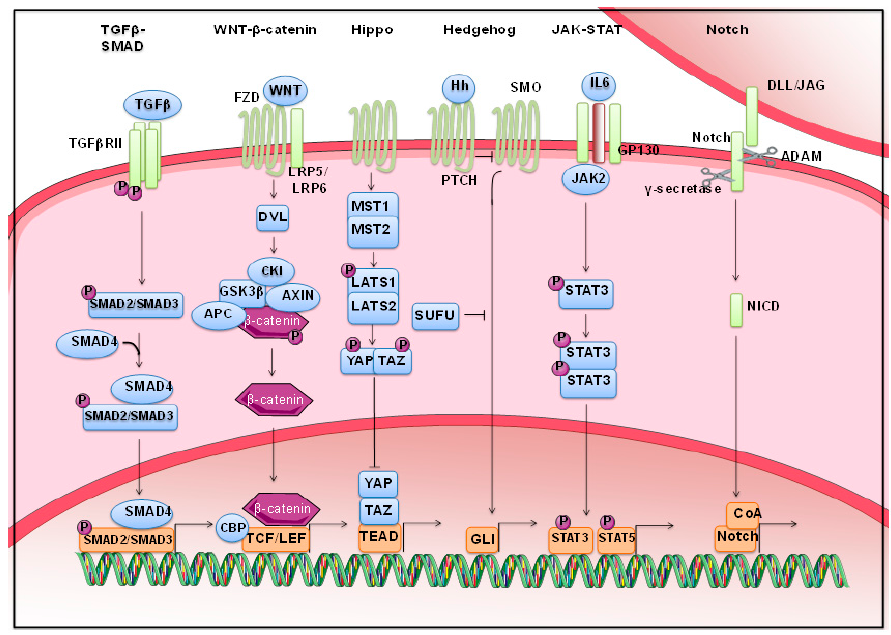
Figure 2. CSCs-activated signaling pathways: Schematic representation of the signaling pathway responsible for induction and maintenance of CSC state. The transcription factors, co-factors, main nodes reported are targetable by drugs. (Adapted from Pattabiraman and Weinberg, Nat Rev Drug Discovery, 2014 [44]). Table 1. Prevalence of CSCs-activated signaling pathways in solid tumors accordingly with outcome: Results obtained by R2 on line tool. Clustering the patients in dead and alive for each solid cancer, the values are indicative of how enriched in dead patients are the Hippo, Wnt, Jak/STAT, TGFb, Notch, Hedgehog pathways, based on gene expression data. The values are between 0 and 1 where 0 is the best over-representation. The color scale (from violet to white) groups the 6 CSCs pathways from the highest to the lowest enriched, among each TCGA (The Cancer Genome Atlas) dataset. Patient Status